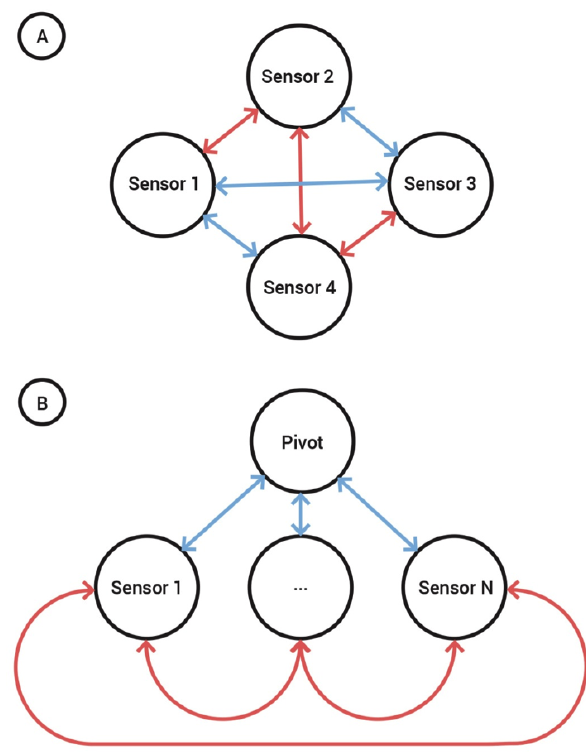
Figure 3: A) A set of sensors and the relations known between them. The red transformations can be found easily as long as the blue ones form a connected graph (i.e. as long as no sensor is outside of the graph, unrelated to the others). B) The pivot mechanism is applied to complementing the already-known transformations with missing